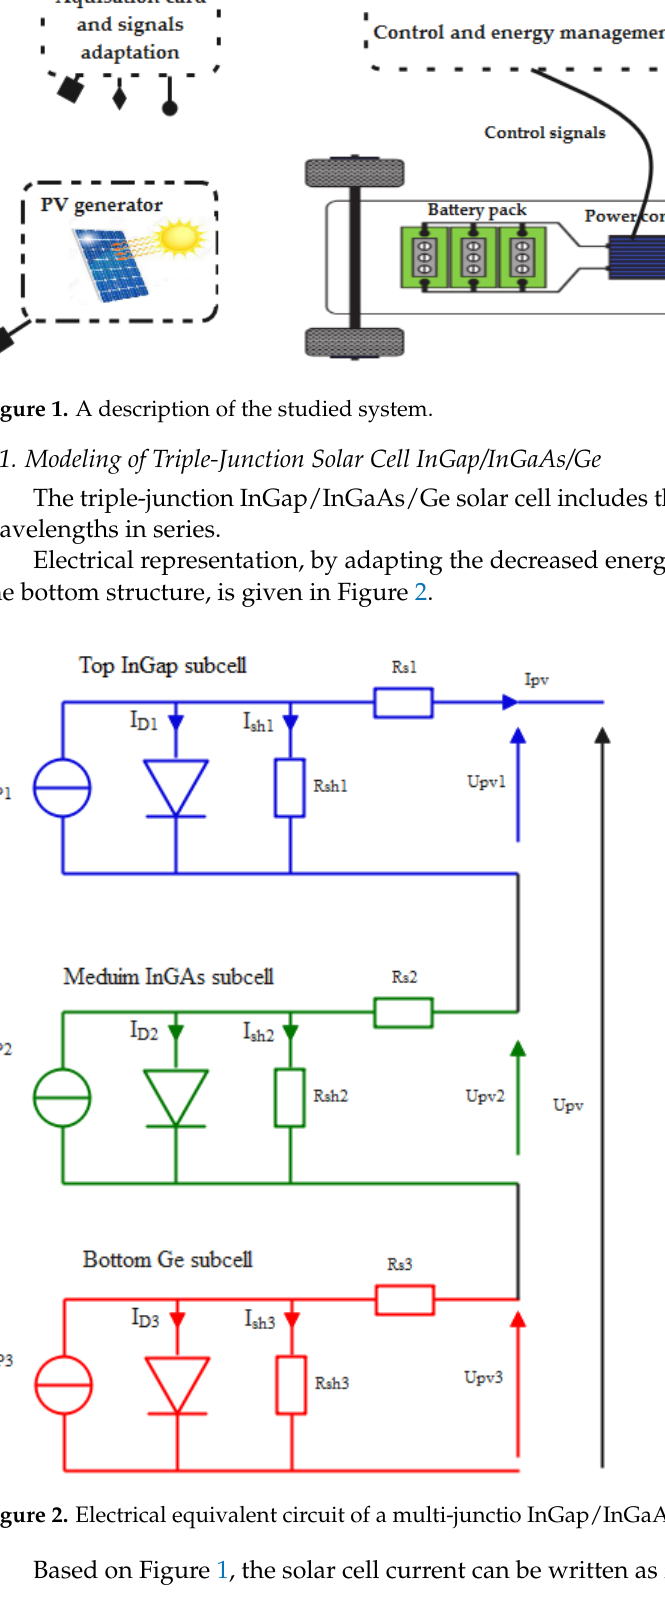
Figure 2. Electrical equivalent circuit of a multi-junctio InGap/InGaA/Ge solar cell. Based on Figure 1, the solar cell current can be written as follows in Equation The diode saturation current